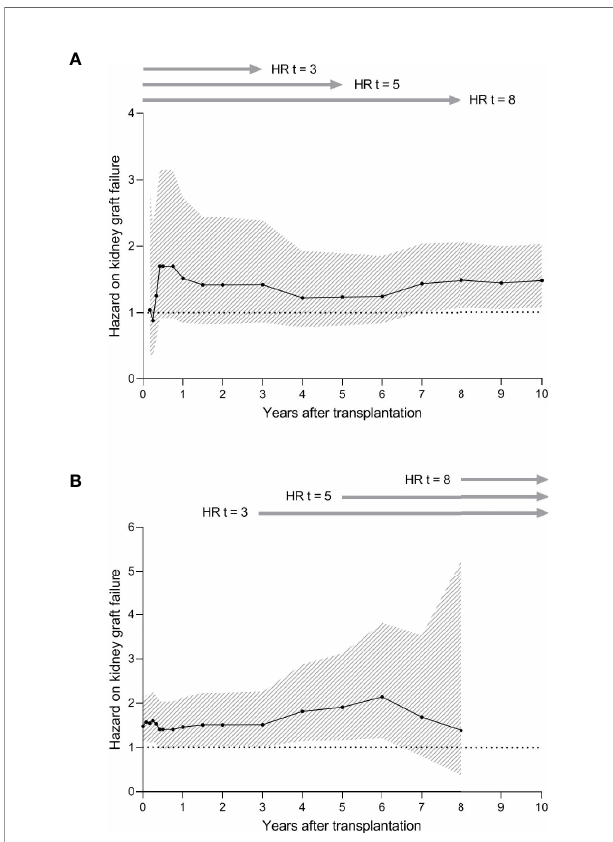
FIGURE 5 | Hazard ratios (HRs) and 95% con fi dence intervals (CIs) for the effect of the Shared T-cell Epitopes (STEP) score on death-censored kidney graft failure. (A) HRs and 95% CIs for the STEP score on death-censored kidney graft failure at different virtual endpoints after transplantation (2-3-4-5- 6-9-12-18 months and 2-3-4-5-6-7-8-9-10 years after transplantation). For all time spans, the number of recipients included in the analysis is 190. Due to the low number of events at 1 month transplantation, the HRs for this time span could not be calculated. (B) HRs and 95% CIs for the STEP score on death-censored kidney graft failure among patients who did not experience graft failure before different time points (1-2-3-4-5-6-9-12-18 months and 2- 3-4-5-6-7-8 years after transplantation). These analyses were performed by setting the graft survival to 100% at each time point and by consequently calculating the HR and 96% CIs at 10 years after transplantation. The number of recipients at risk for each time span is shown in Supplementary Table 4 . Due to the low number of events at 9 and 10 years after transplantation, the HRs for these time spans could not be calculated. HRs were calculated considering the covariates implemented in the initial multivariable model (STEP score). For both graphs, the black line represents the HR and the grey area represents the 95%